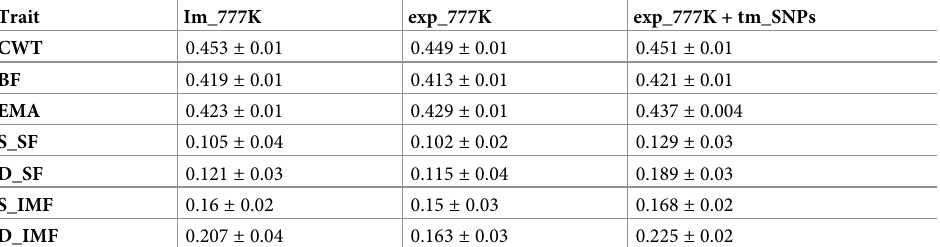
Table 5. Carcass traits average correlation between the GEBV and corrected phenotypic values ( y c ) and standard error for 10-validation set. Meat quality traits average correlation between the GEBV and corrected phenotypic values ( y ) and standard error for 10-validation set. c